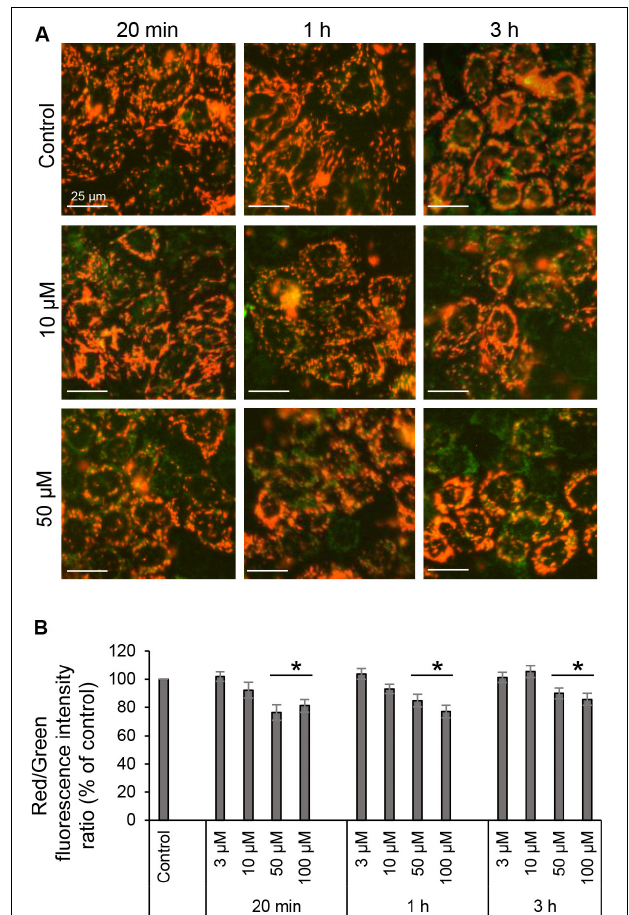
FIGURE 8 | Mitochondrial membrane potential of living intestinal epithelial cells in response to 3O-C 12 -HSL. (A) Cells were either treated with 0.02% DMSO as a diluent (Control), or exposed to 3, 10, 50, or 100 µ M 3O-C 12 -HSL and then stained with sensor JC-1 that exhibit MMP-dependent accumulation in mitochondria, indicated by a fluorescence shift between red and green. Living cells were visualized using IncuCyte Zoom live cell imaging and analysis system to measure fluorescence intensities. All images are merged between red (energized mitochondria) and green (depolarized mitochondria) fluorescence; orange indicate polarized mitochondria. Image size is 100 µ m × 100 µ m. Bar: 25 µ m. (B) Quantification of the mitochondrial polarization. The level of mitochondrial polarization was calculated as the ratio between red and green fluorescence intensities, and values were normalized to the diluent control (100%). Columns represent the mean ± SE for the ratio between red and green fluorescence intensities. Significant differences are indicated with * P < 0.05, as analyzed by two-tailed Student’s t -test. Data from at least six independent experiments performed on separate days on different cell passages, and at least 1000 cells per condition were